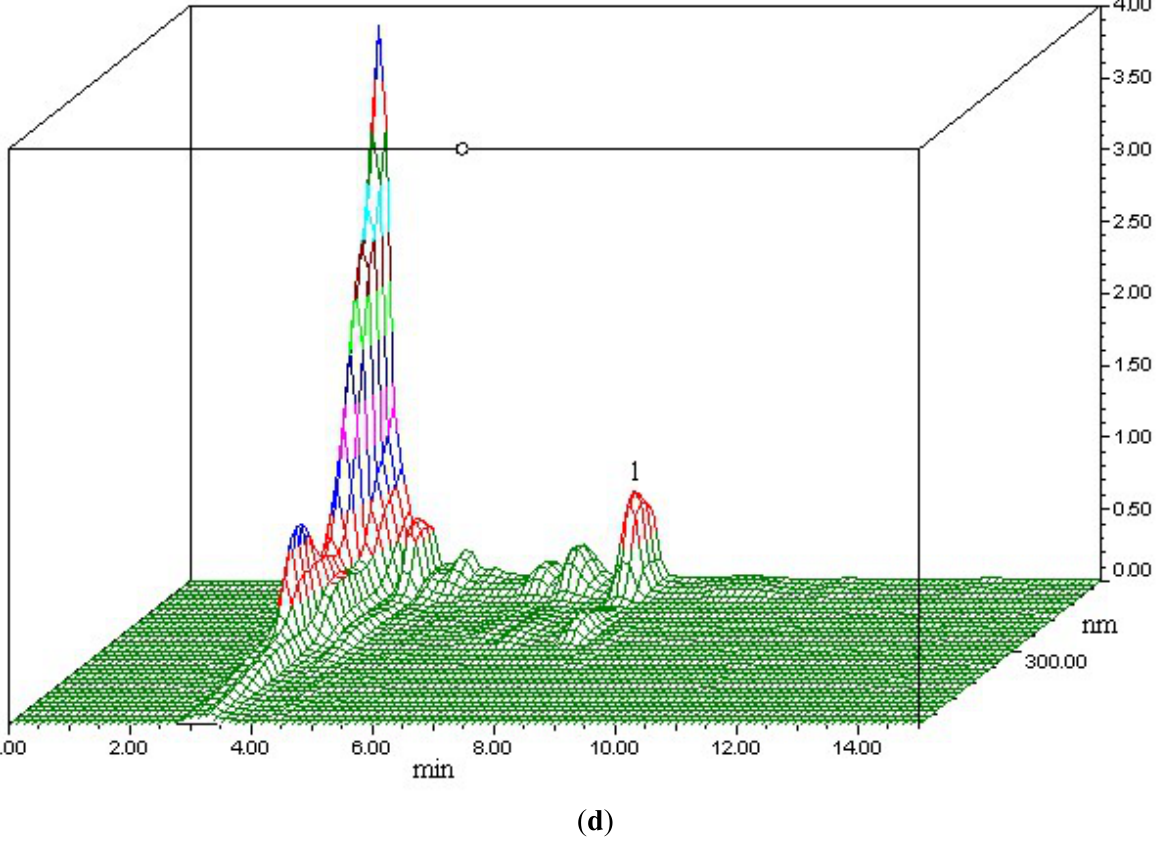
Figure 3. Product ion mass spectra of [M − H] − . ( a ) Salidroside ([M − H] − , m/z